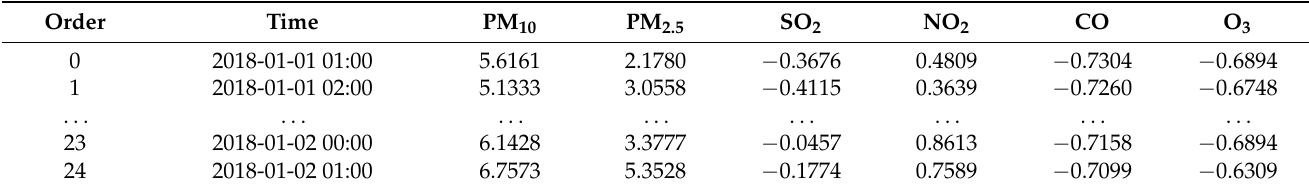
Table 3. The example of the